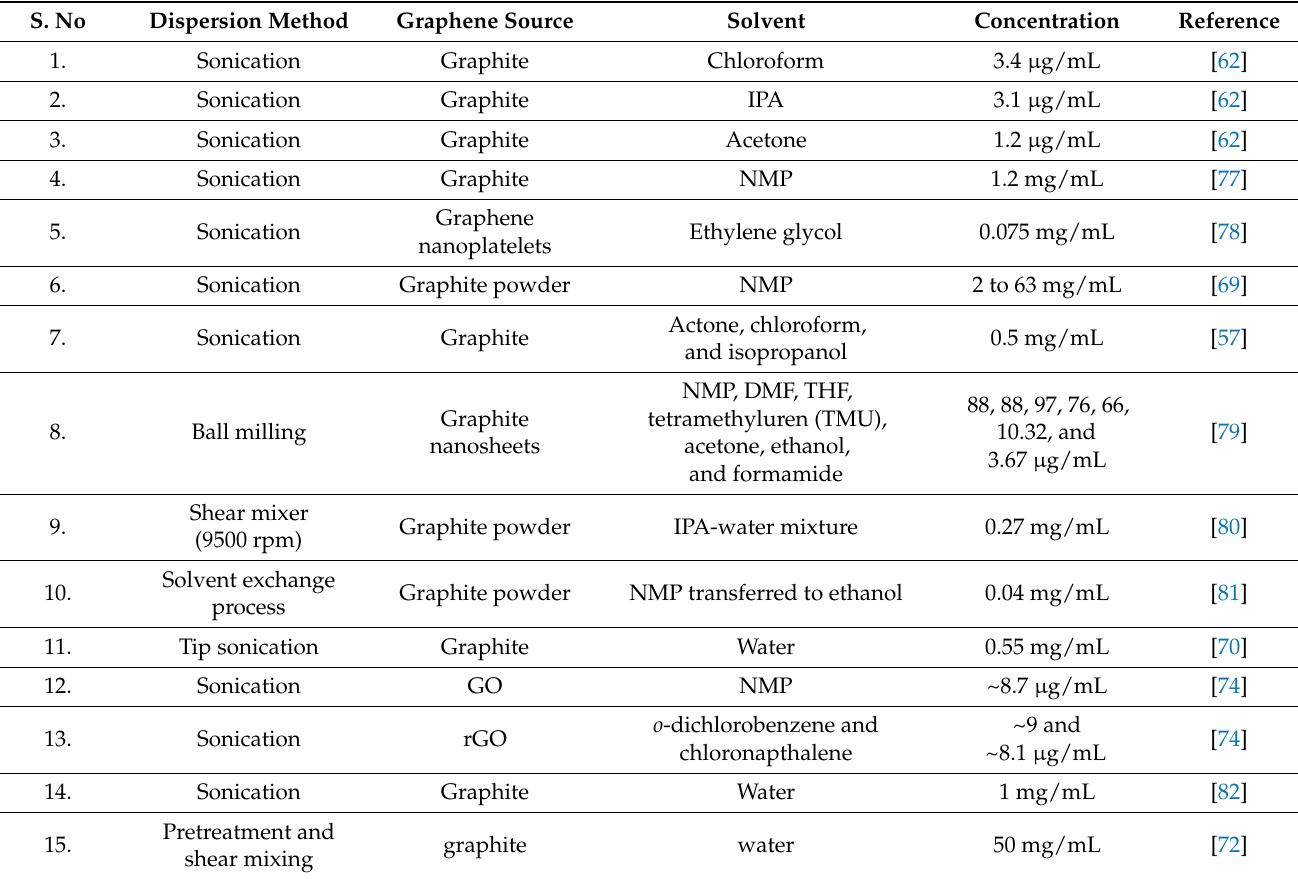
Table 1. A comparison of dispersion methods, graphene sources, solvents, and obtained graphene concentration values. S.